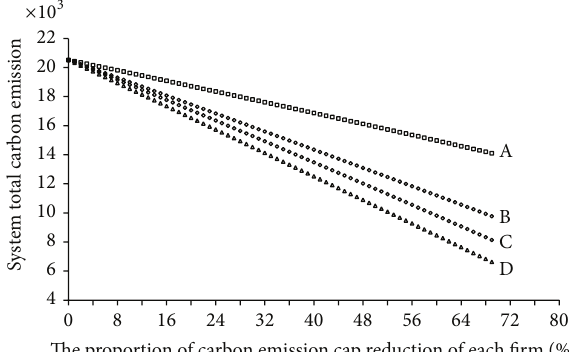
Figure 4: System emissions when each company reduces carbon emissions by